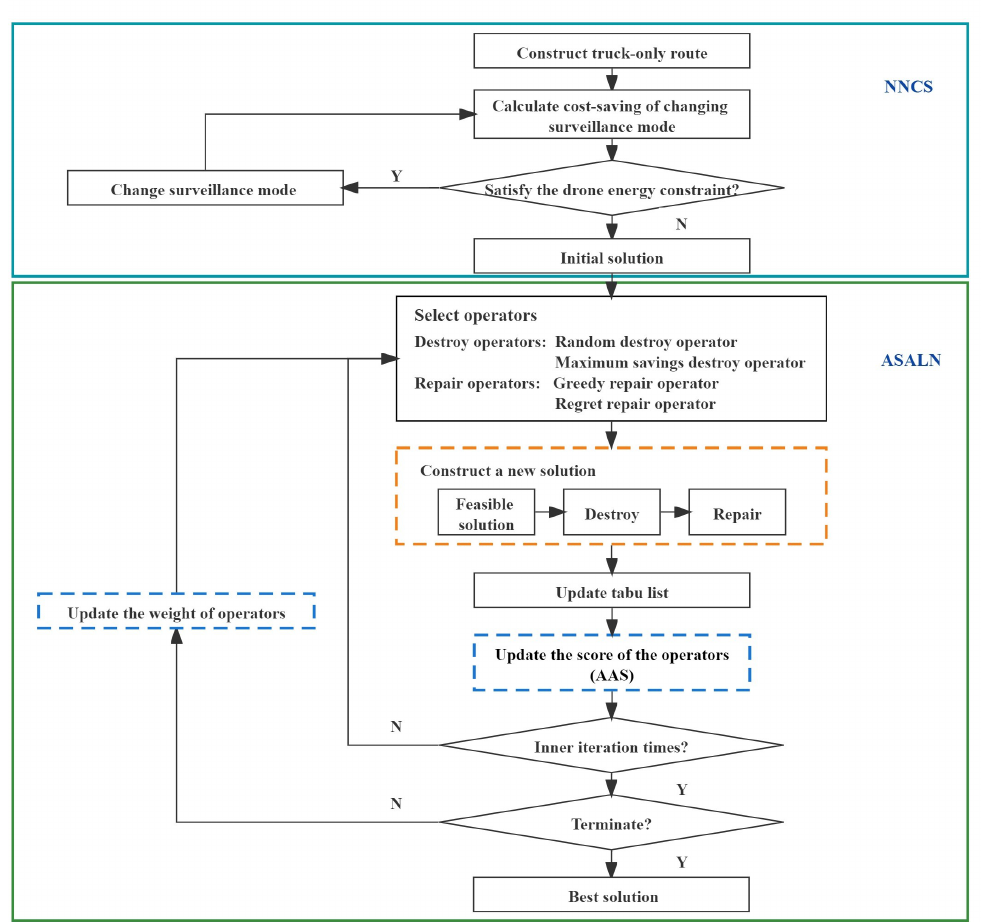
Figure 2. The flowchart of the proposed method.